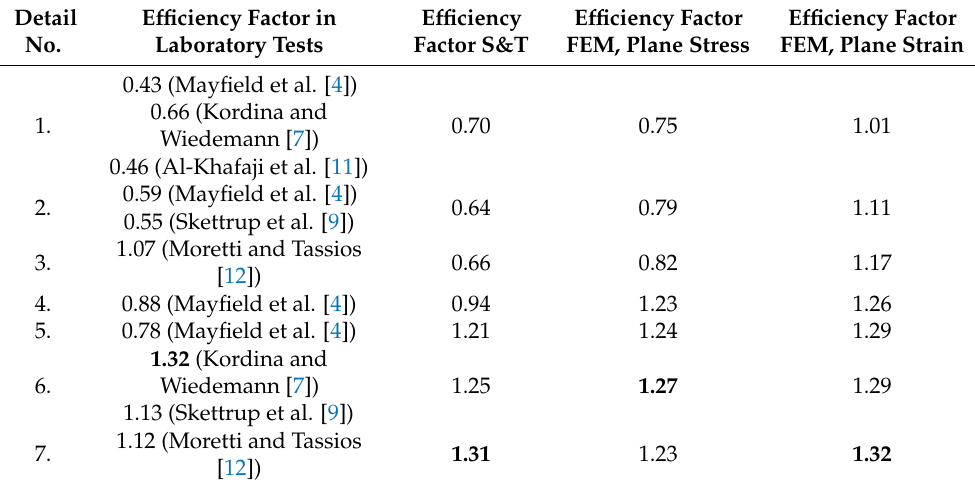
Table 9. Efficiency factors obtained in authors’ analyses and in laboratory tests—the case of elements with the same cross section heights (maximal values in bold).